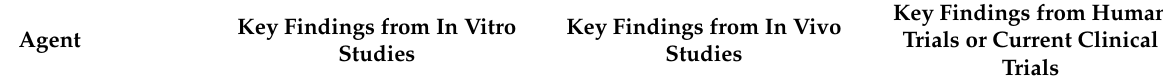
Table 2. Key findings from preclinical and clinical research on canine and human OS, with PIs that are in clinical